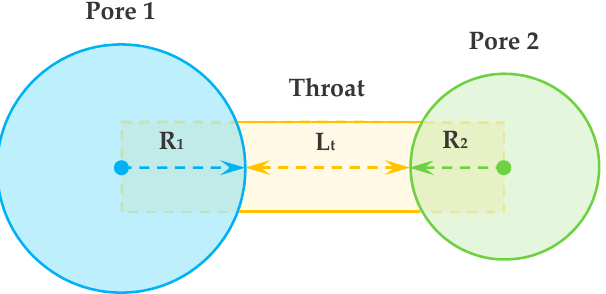
Figure 4. Illustration of pore and throat configuration in the pore network used for diffusion simu- lation.